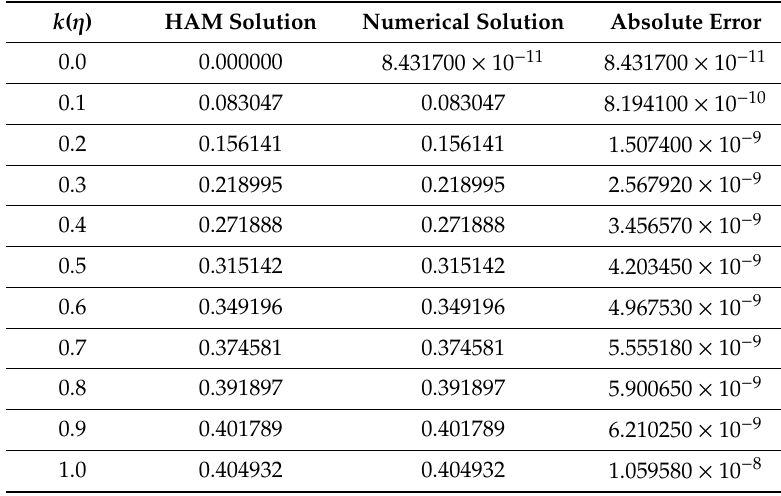
Table 2. Comparisons of the HAM and numerical